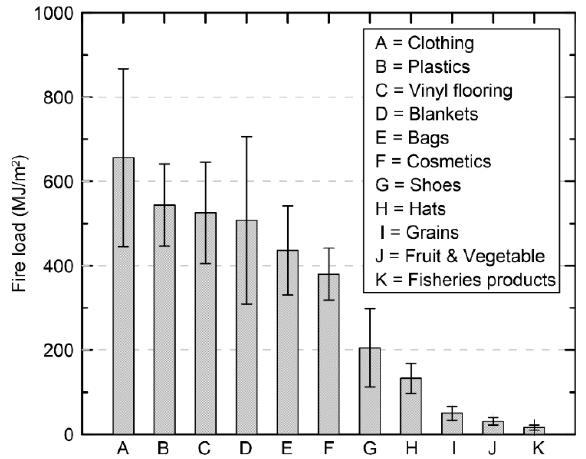
Figure 2. Comparison of fire loads by store type through field survey to select major combustibles in traditional markets.